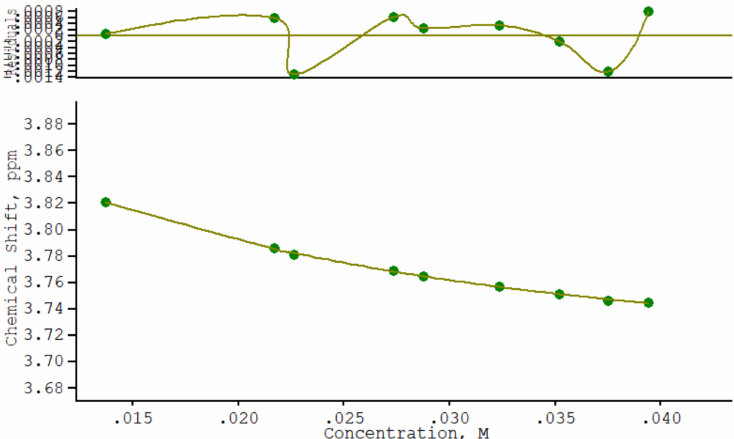
Figure 3. The chemical shift of the H 3 proton of β -CD as a function of the NTBC concentration and the experimental data fitting (by WinEQNMR) for the NMR titration of β -CD with NTBC (a magnification of the residuals is also presented).